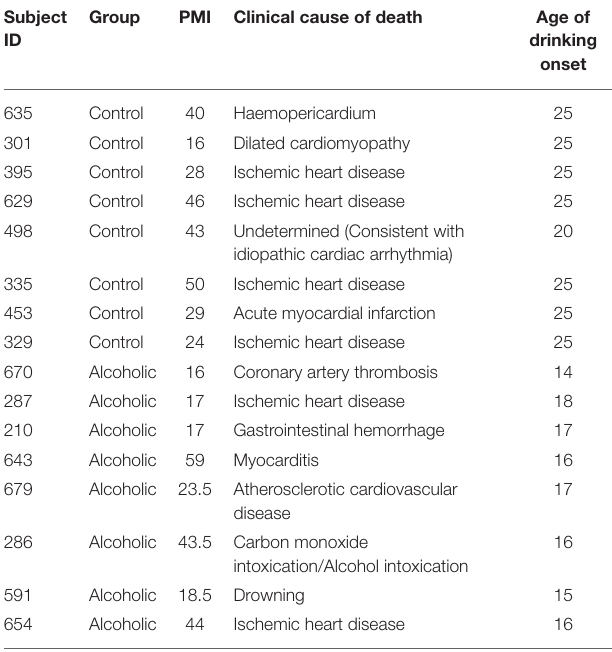
TABLE 1 | Case characteristics of male human subjects used for IHC analysis in the post-mortem